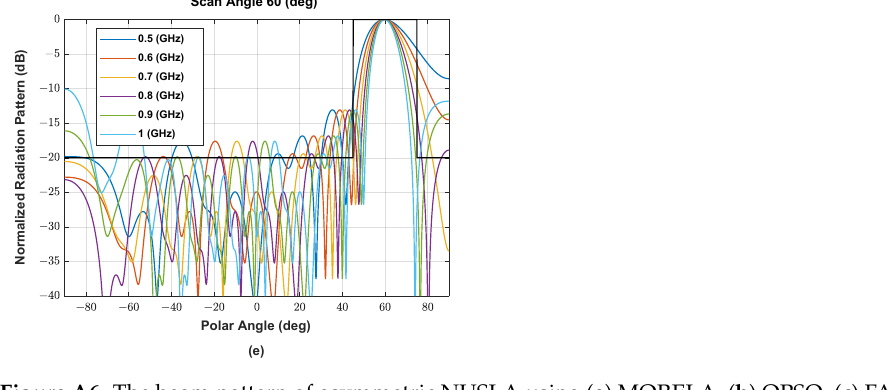
Figure A6. The beam pattern of asymmetric NUSLA using ( a ) MORELA, ( b ) QPSO, ( c ) FA, ( d ) SSA, and ( e ) MALO in case for θ 0 =